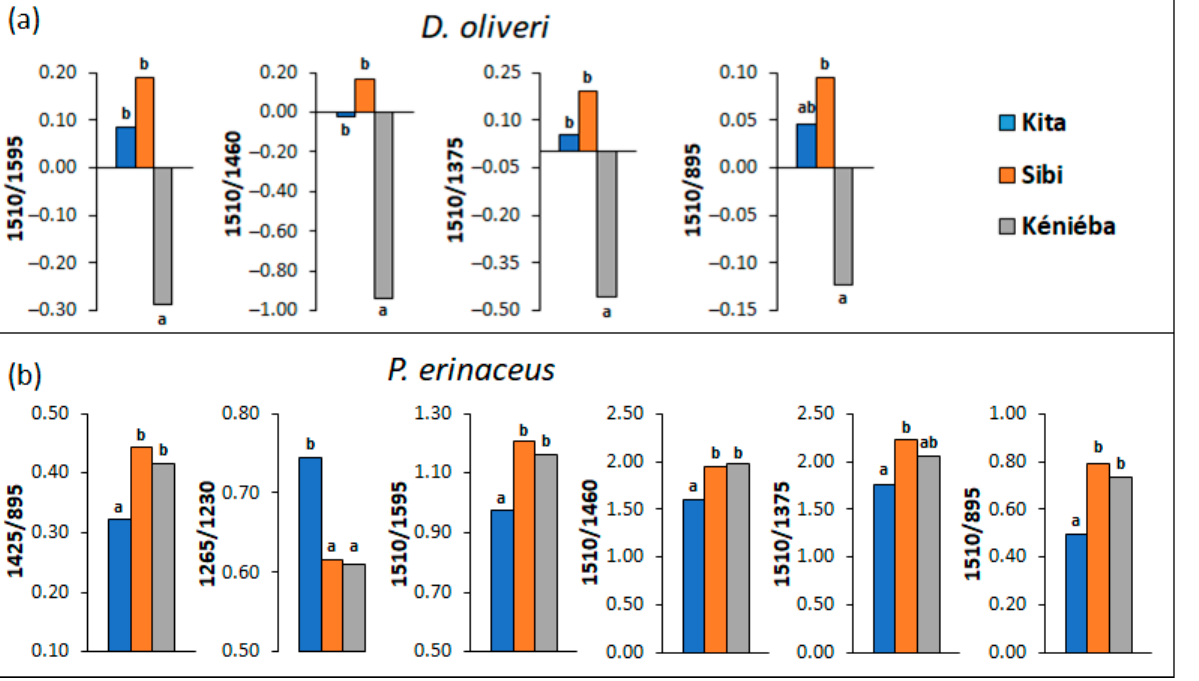
Figure 6. Bar chart of the mean values of FTIR ratios showing significant differences between samples from the three areas; ( a ) for D. oliveri ( n = 5 for Kita, n = 6 for Sibi and n = 6 for Kéniéba), ( b ) for P. erinaceus ( n = 6 for Kita, n = 5 for Sibi and n = 6 for Kéniéba); (the labels a, ab, and b refer to group classi fi cation in ascending order of the Student–Newman–Keuls post-hoc test).